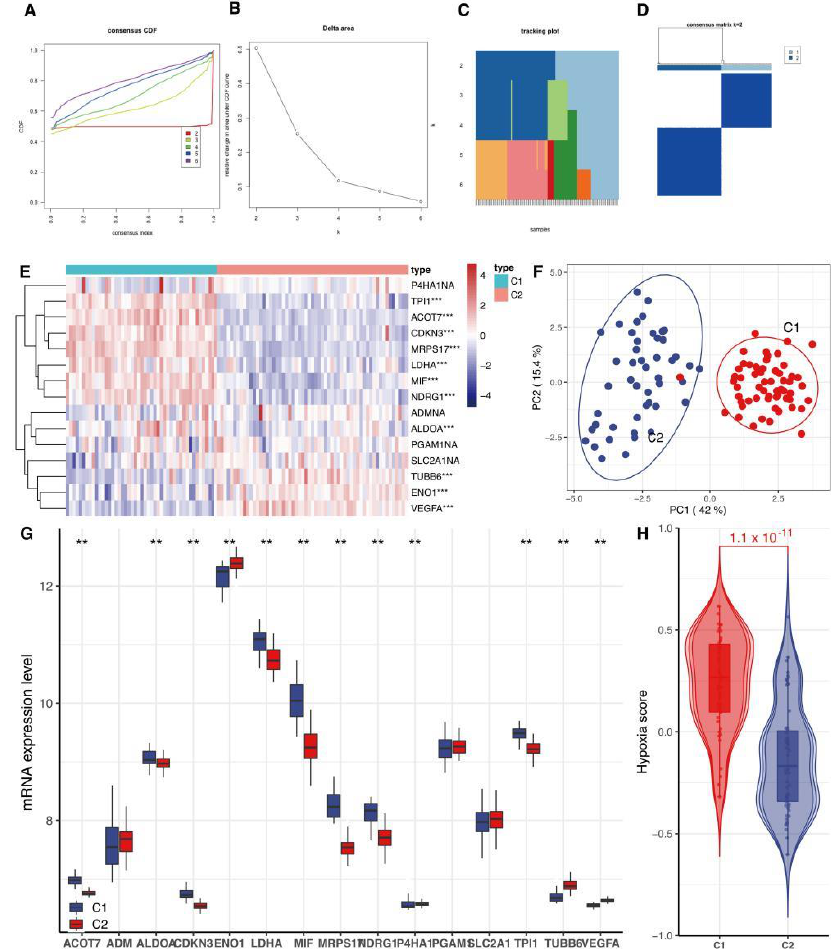
Figure 2. Classification of hypoxia status. ( A ) CDF delta area curve of consensus clustering, indicating the relative change in area under the cumulative distribution function. CDF curve for each category number k compared with k − 1. The horizontal axis represents the category number k, and the vertical axis represents the relative change in area under CDF curve. ( B ) CDF curve; different colors reflect different cluster numbers, the horizontal axis represents the consensus index, the vertical axis stands for CDF. ( C , D ) Heatmap of sample clustering at consensus K = 2. ( E ) Heat map of the expression of 15 hypoxia gene expression signatures between cluster1 (C1) and cluster2 (C2). ( F ) PCA analysis of two subtypes. PCA: principal component analysis. ( G ) Box plots show differentially expressed 15 hypoxia gene expression signatures between C1 and C2. ** means p < 0.01, *** p < 0.001, ns means not statistically significant. ( H ) Violin graphs of hypoxia scores between C1 and C2. CDF: cumulative distribution function .